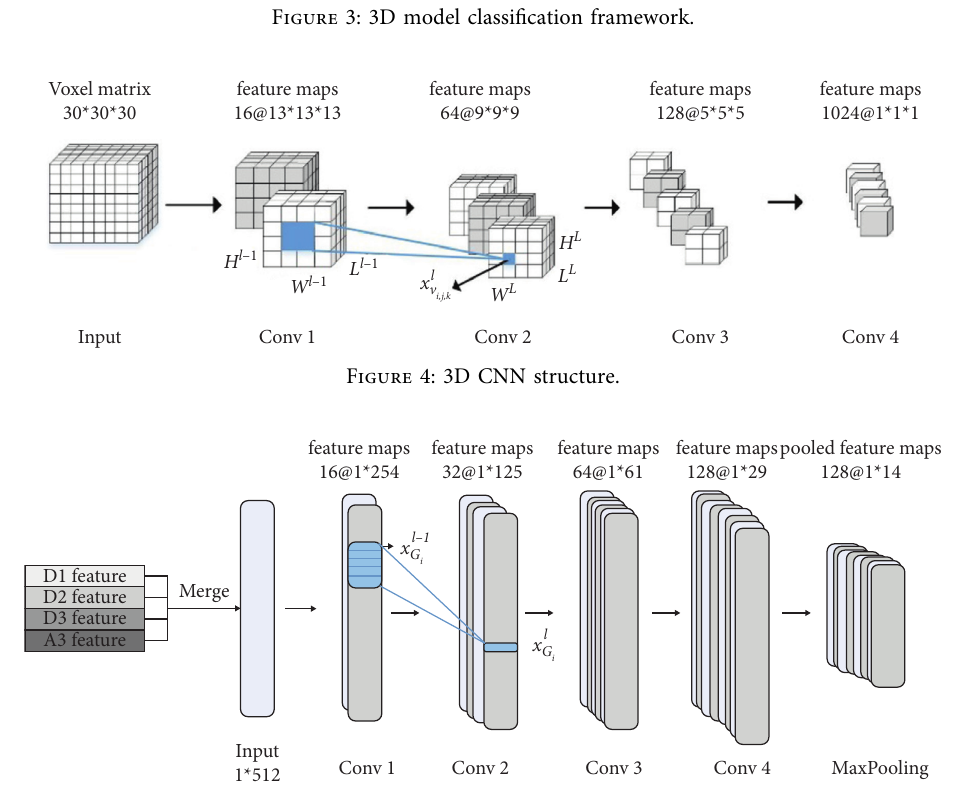
Figure 5: 1D CNN